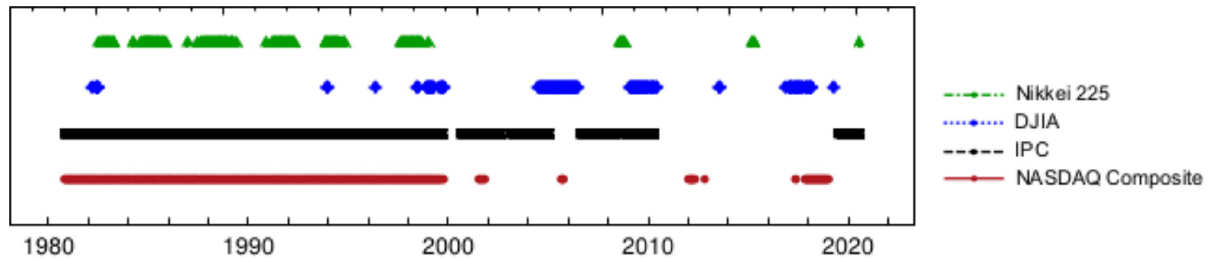
Fig 8. Colored points represent the dates where events from Fig 7, have a p -value below the α = 0.05 significance level, i.e. dates where the statistical behavior of the durations of the uninterrupted trends are more distant from a geometric with parameter p = 0.5. For easy reading colored points are